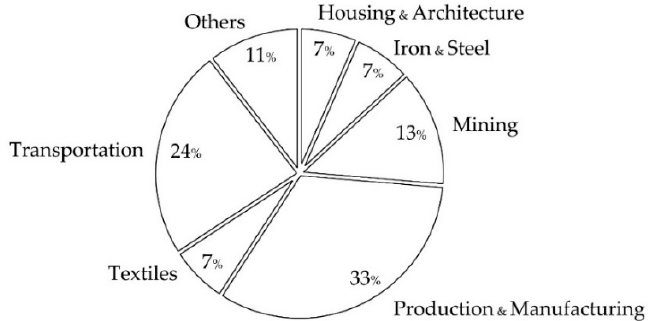
Figure 15. Categories of Belgium by the industrial heritage in ERIH, 2020.